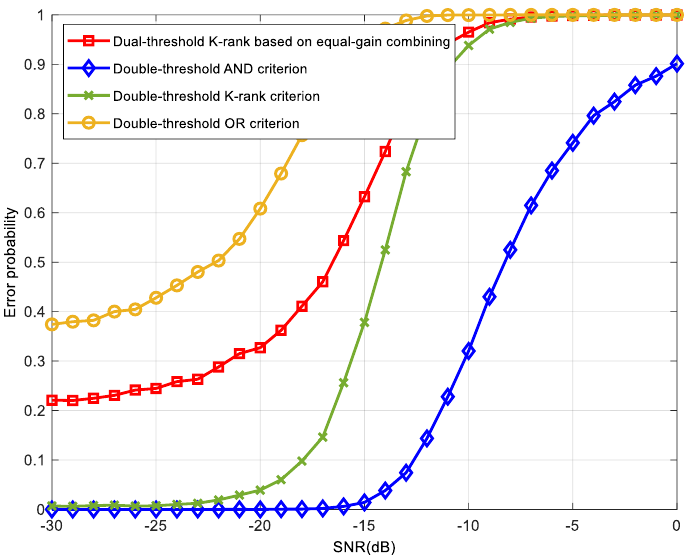
Figure 3. Detection probability of different fusion criteria (Rice factor K = 5 dB, noise uncertainty ρ = 1.01).